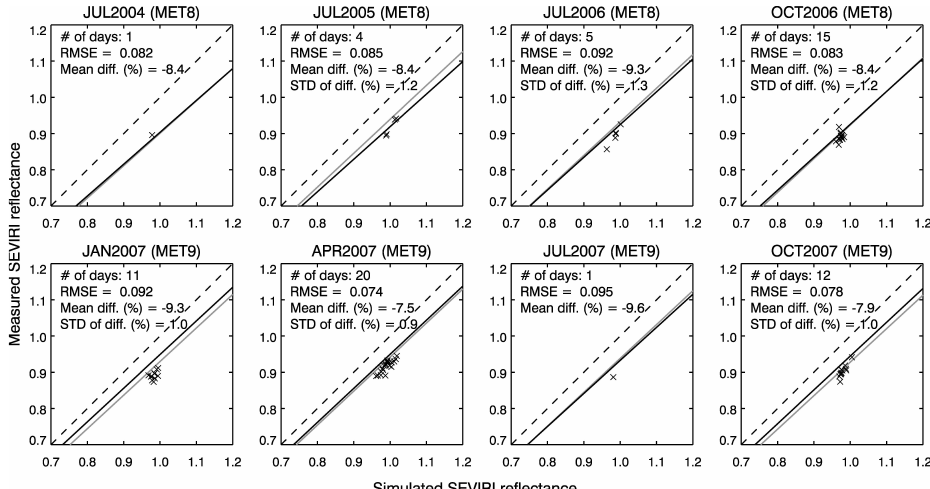
Fig. 10. Comparison of Method 3 (crosses) against Method 1 (grey solid line) and Method 2 (black solid line) for (top) Meteosat-8 and (bottom) Meteosat-9 SEVIRI 0.640-µm channels. For Method 3, the daily average is calculated when the number of selected DCC targets is greater than 10. On a daily basis, differences between measured and simulated reflectances are calculated and their monthly mean and standard deviation are given on each panel. Dashed lines are perfect matches.